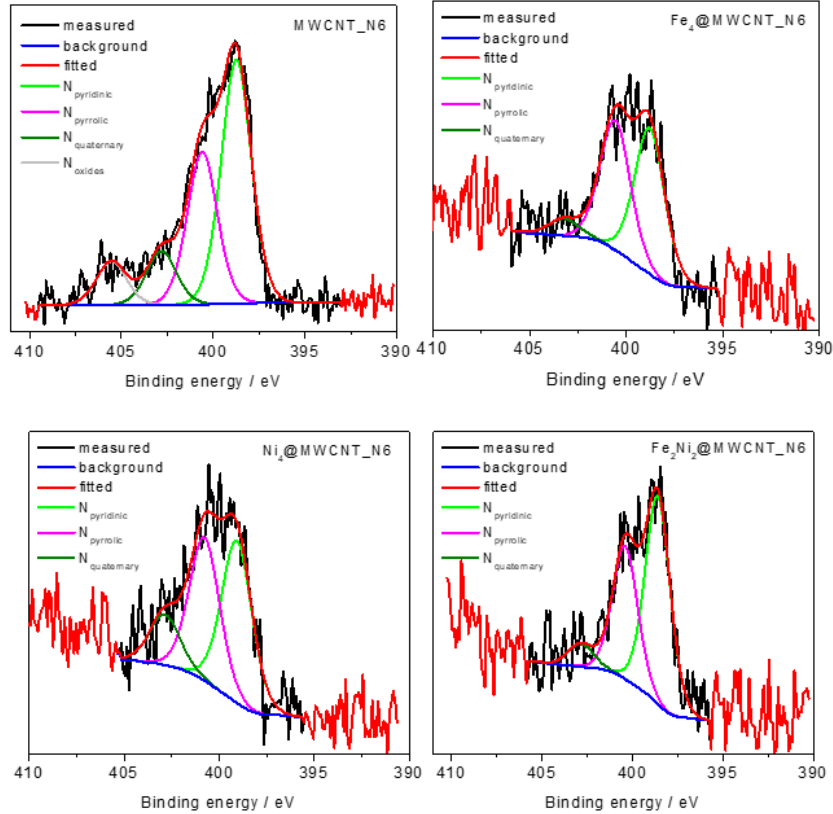
Figure 1. Deconvoluted N1s high-resolution spectra of MWCNT_N6-based materials (green: pyri- dinic N; pink: pyrrolic N; olive: quaternary N; gray: